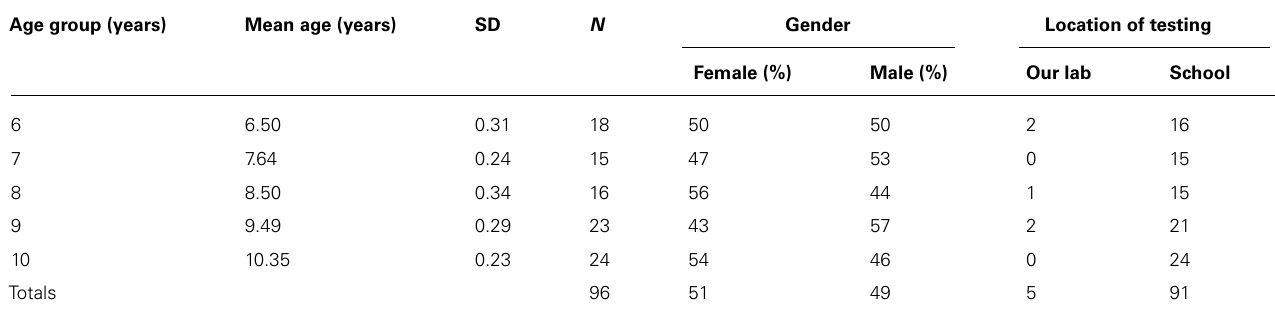
Table 1 | Number of participants within each age and gender group. Age group